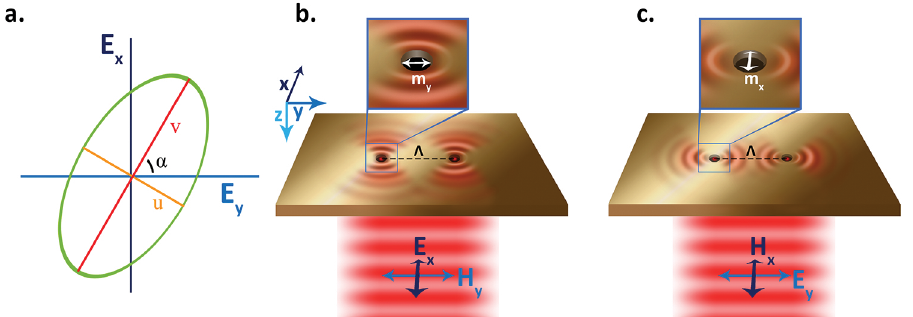
Figure 1. Plasmonic platform for the study of optical singularities. ( a ) The polarization ellipse, which can be used to describe the polarization of light in a plane. Here, the lengths of the short and long axes, u and v , are labeled, as is α , the angle that the long axis makes with the y -axis. ( b ) Sketch of a plasmonic system that we envision can be used to study optical singularities on the nanoscale. Multiple holes, each separated by Λ , are arranged in a line on an optically thick metallic film. Illumination from the bottom side, in this case at normal incidence with H oriented along y and E along x , excites dipoles in the holes (in this case, predominately m ), which radiate surface plasmon polaritons (SPPs) on the top y surface of the film. We look for singularities in the electric field distributions that result from the superposition of all f the SPP waves. ( c ) The same system as in (b), but with